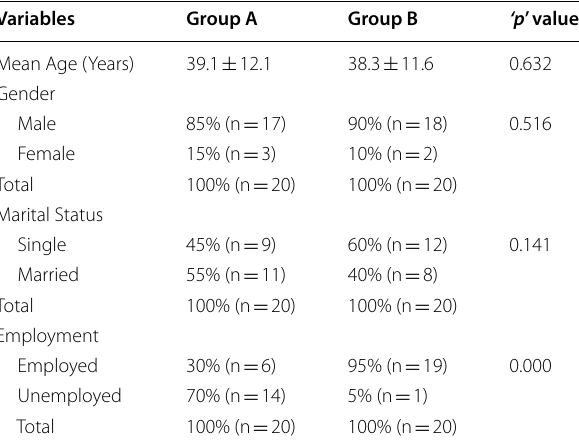
Table 1 Comparison of sociodemographic characteristics of study